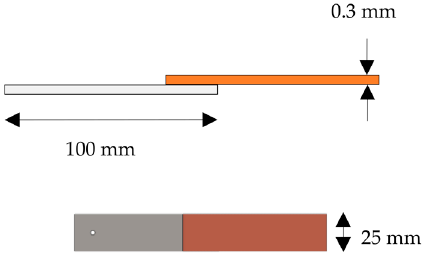
Figure 3. Dimensions of copper–steel single-lap-shear coupons.